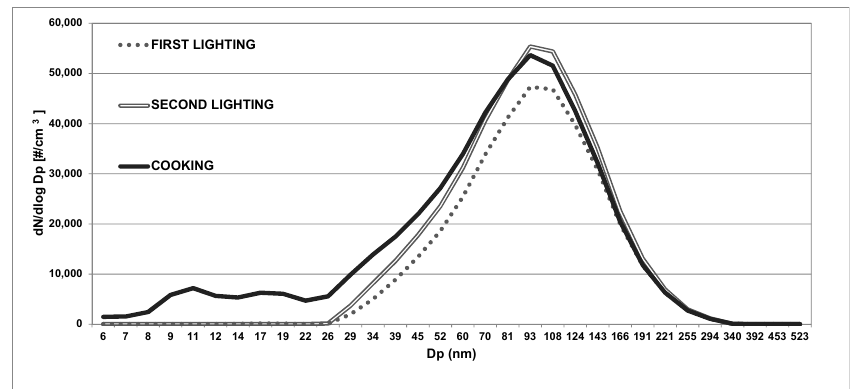
Figure 4. Size distribution of UFP emitted during the two lightings and cooking for House 1 (for example).